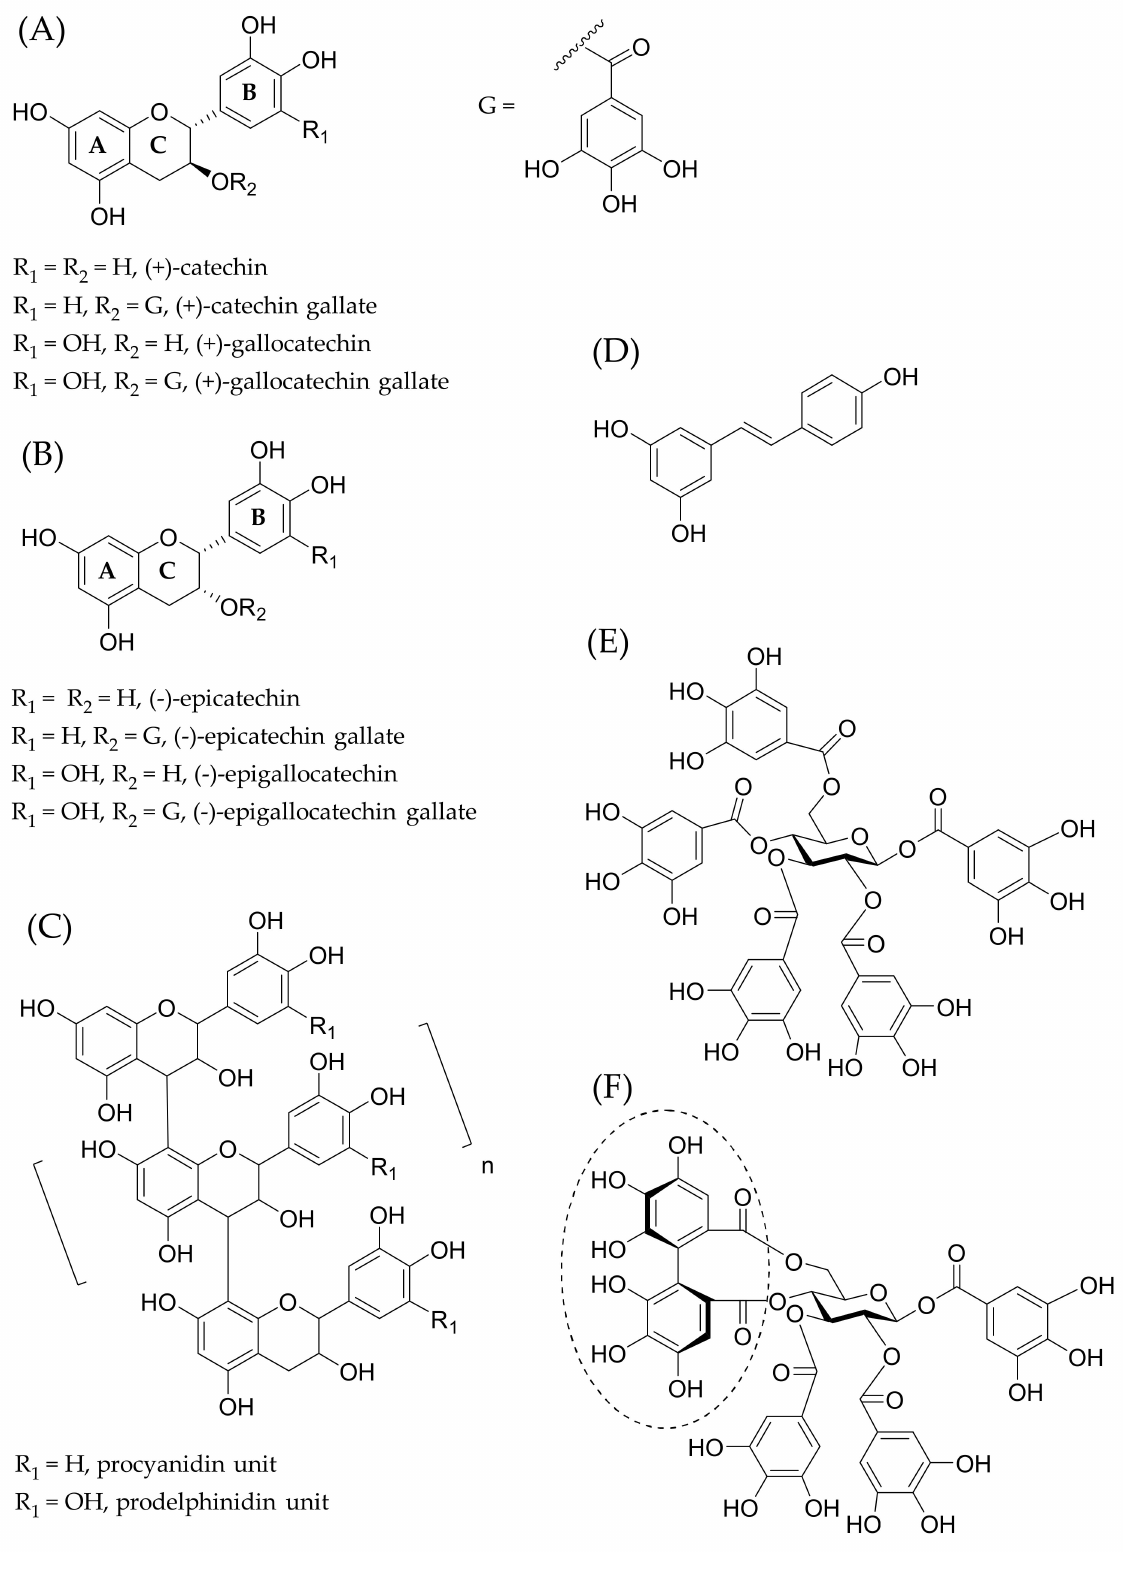
Figure 1. Examples of polyphenols having affinities to lipids: ( A ) flavan-3-ols with 2 R ,3 S stereo- chemistry, ( B ) flavan-3-ols with 2 R ,3 R stereochemistry, ( C ) B-type proanthocyanidins linked by a C4–C8 bond, ( D ) resveratrol, ( E ) pentagalloylglucose and ( F ) tellimagrandin II (the characteristic hexahydroxydiphenoyl group for ellagitannins is